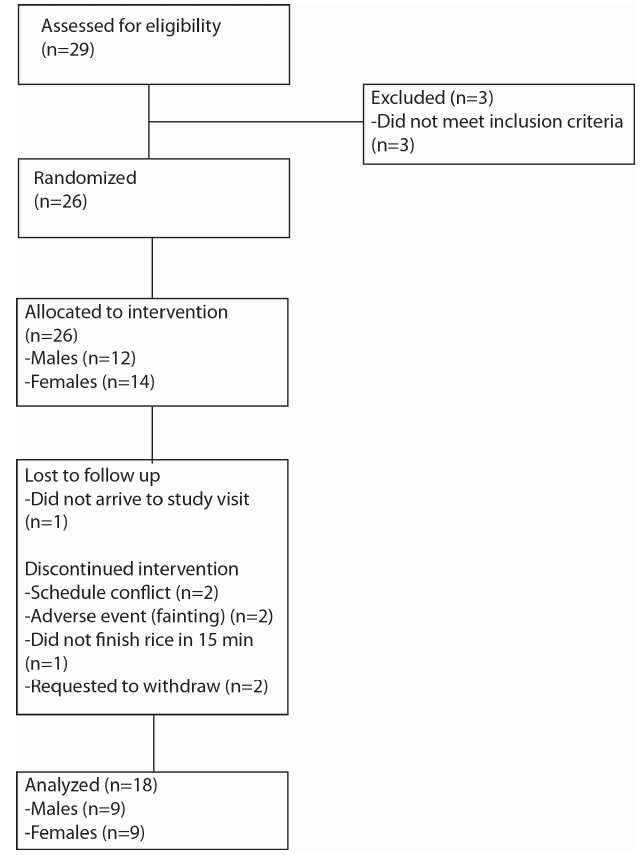
Figure 1. Flow diagram depicting the passage of subjects through the intervention.